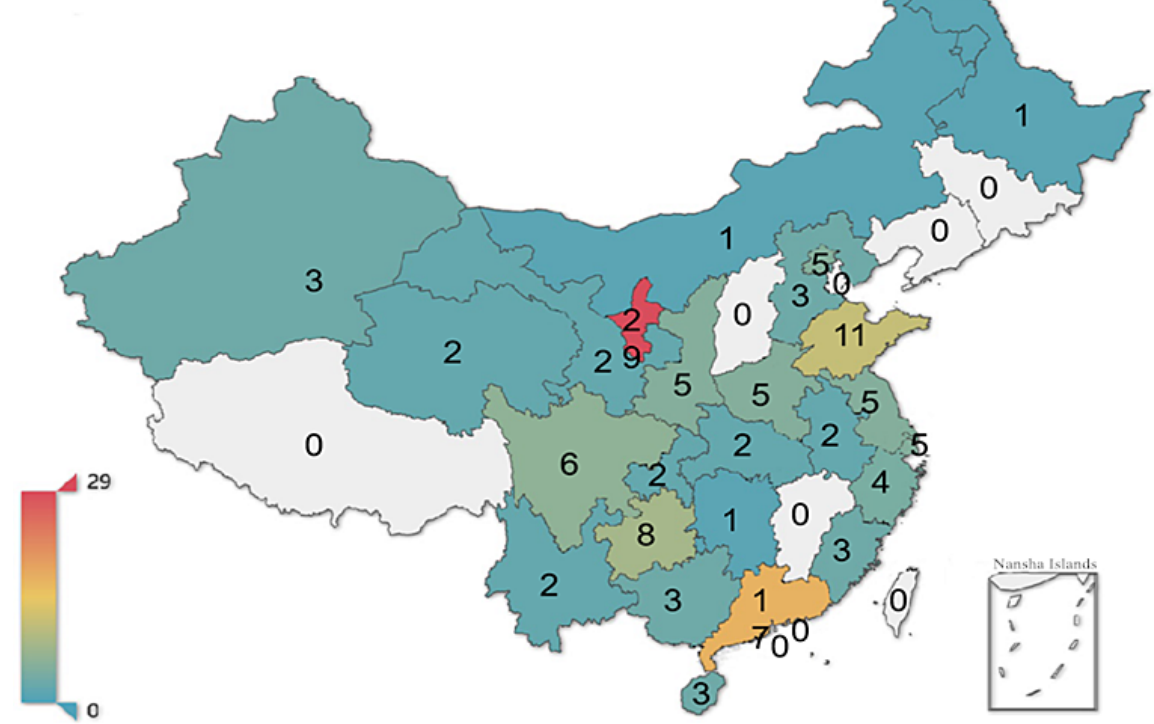
Figure 2. Heat map of number of internet hospitals in Chinese